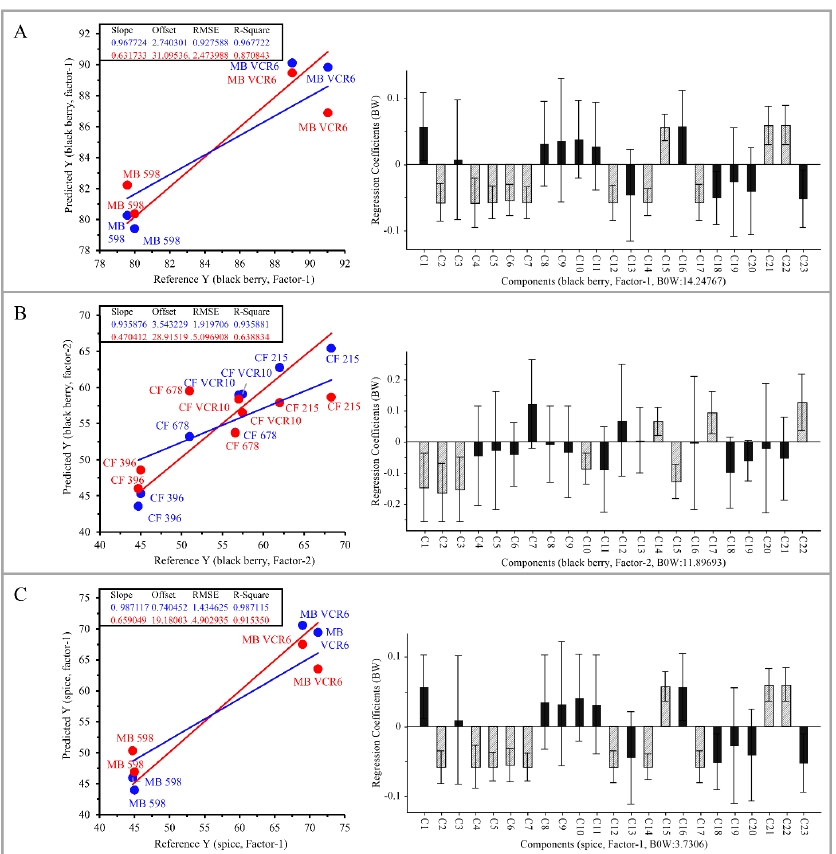
Figure 5. PLSR analysis of black berry sensory attributes of Malbec (A) and Cabernet Franc ( B ) and spice sensory attributes of Malbec ( C ) with volatile compounds. Normalized and estimated regression coefficients from the PLSR model showed significant correlations between volatile compounds and black berry and spice sensory aroma attributes in these wine samples. Bar with slash indicates a significant effect ( p < 0.05).